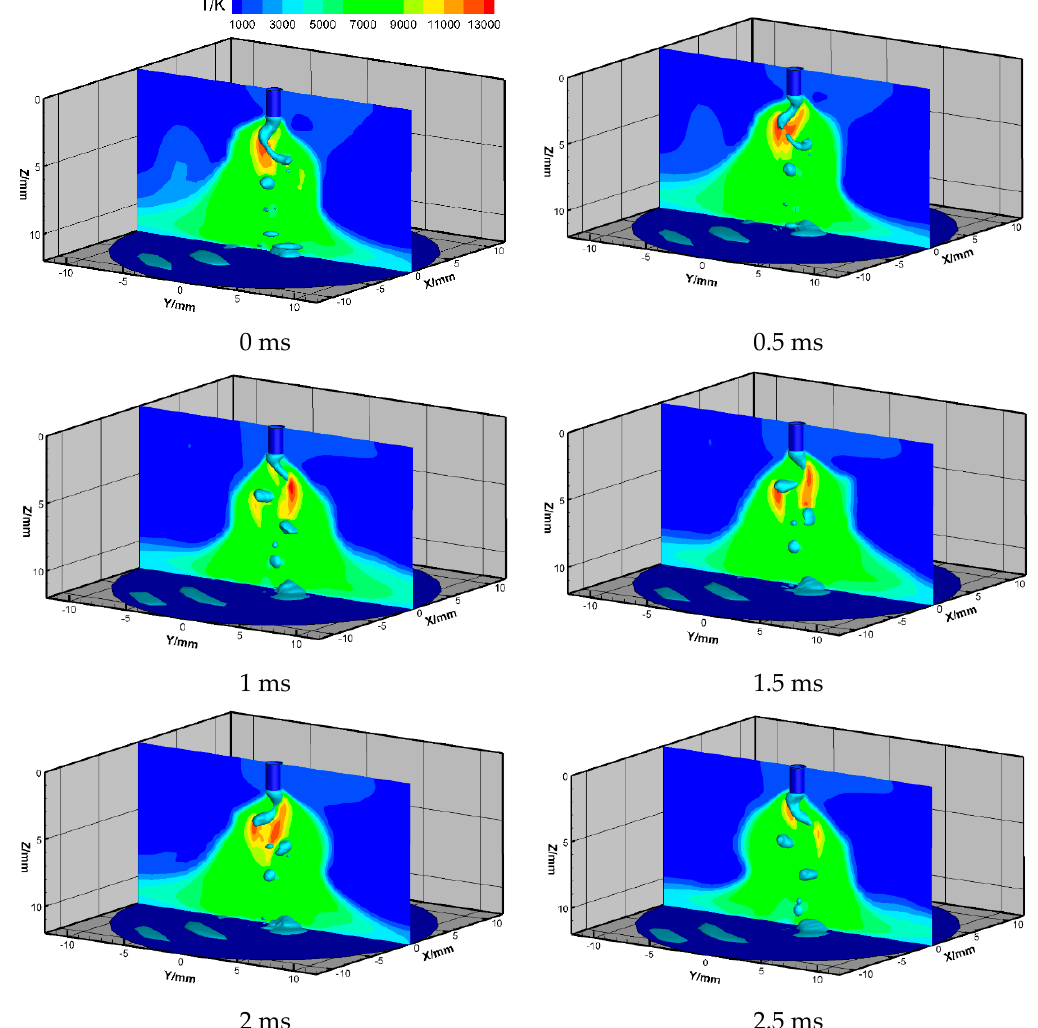
Figure 3. Arc temperature field for high-current gas metal arc welding (GMAW).